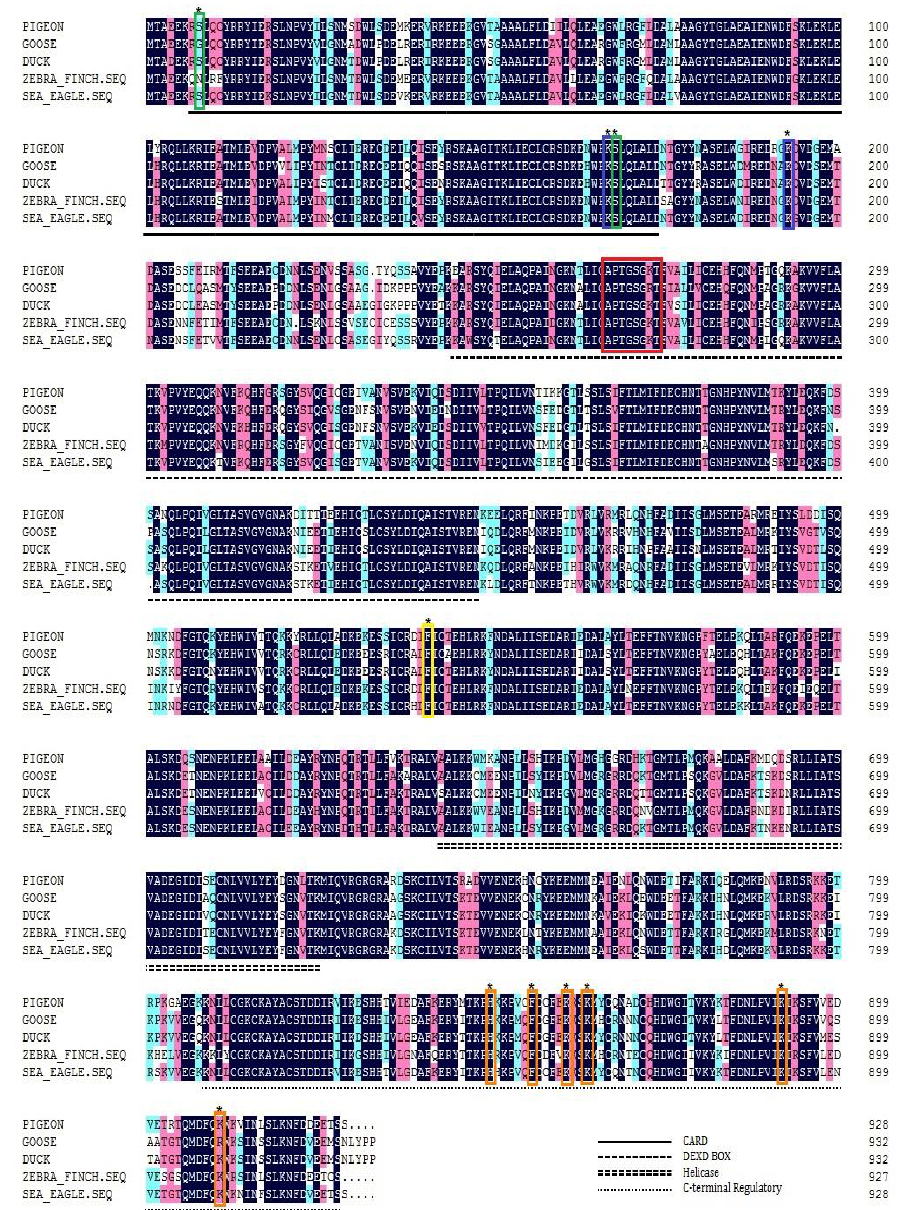
Figure 1. Amino acid alignment of pigeon, goose, duck and zebra finch RIG-I. Black shading indicates amino acid identity, and the green frame indicates the phosphorylation sites. The blue frame denotes ubiquitination sites, and the red frame indicates the ATP-binding motif. The yellow frame indicates the critical residue for the interaction between CARDs and HEL2i, and the orange frame denotes the critical residues for RNA ligand binding.